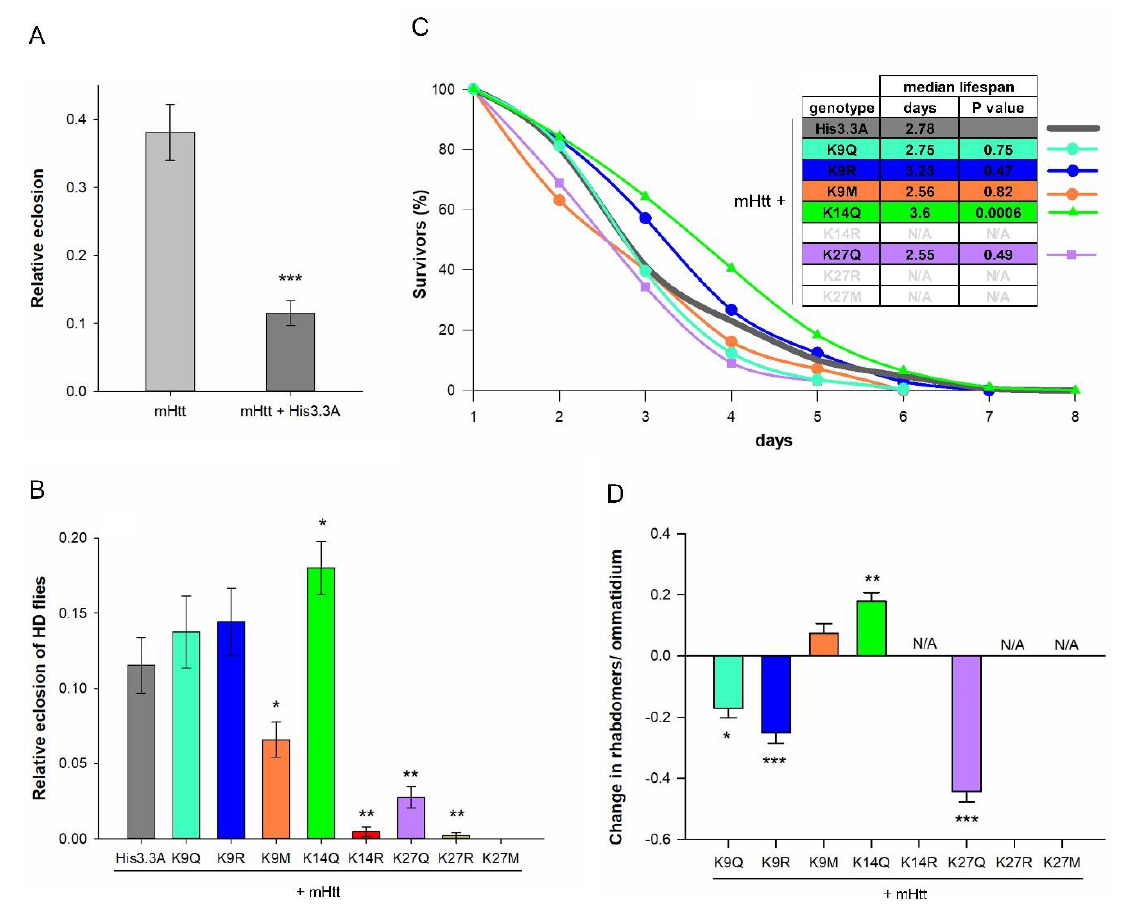
Figure 2. K14Q modification of H3.3 ameliorates HD phenotypes. ( A ) Relative eclosion rates of female flies expressing mHtt or co-expressing mHtt + His3.3A in the nervous system. The expression of wild-type His3.3A transgene decreased the eclosion rate of HD flies; thus, in all further studies, mHtt + His3.3A co -expressing flies served as controls. The bars show the ratio of eclosed flies and error bars represent standard error. n ≥ 1200, *** p ≤ 0.001, Student’s t -test. ( B ) Relative eclosion rates of elav-GAL4 driven mHtt + His3.3A and mHtt + His3.3A-PTM expressing females. The eclosion rate of His3.3A-K14Q -expressing HD flies significantly increased, while the other modifications did not have an effect or worsened the phenotype compared with the control. The bars show the ratio of eclosed flies and the error bars represent the standard error. n ≥ 1200, * p ≤ 0.05, ** p ≤ 0.01, ANOVA. ( C ) Lifespan analysis of female flies co-expressing mHtt + His3.3A or mHtt + His3.3A-PTM in the nervous system. The median lifespan of His3.3A-K14Q -expressing HD flies was significantly longer, while the other modifications did not have a significant effect compared with the control. The graph shows the percentage of survivors as a function of the number of days after eclosion, n ≥ 150, Fisher’s exact test was used for statistical analysis of the median lifespan. ( D ) Pseudopupil assay of elav-GAL4 -driven mHtt + His3.3A-PTM- expressing 2-day-old female flies. The expression of His3.3A-K14Q ameliorated neurodegeneration in HD flies, while the other modifications did not have an effect or worsened the phenotype compared with the control. The bars show the average difference in rhabdomere count compared to the mHtt + His3.3A expressing control and the error bars represent the standard error. n ≥ 10 eyes (≥30 ommatidia/eye), * p ≤ 0.05, ** p ≤ 0.01, *** p ≤ 0.001, ANOVA.